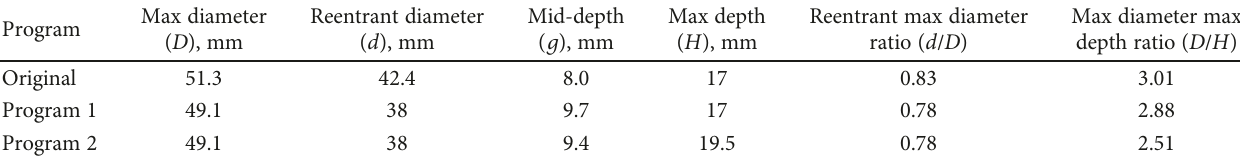
Table 1: Basic size of the combustion chamber.